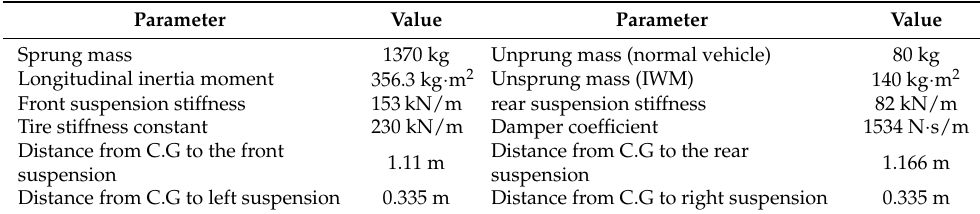
Figure 12. Block diagram of co-simulation of EV suspension. Table 4. Passenger vehicle parameters